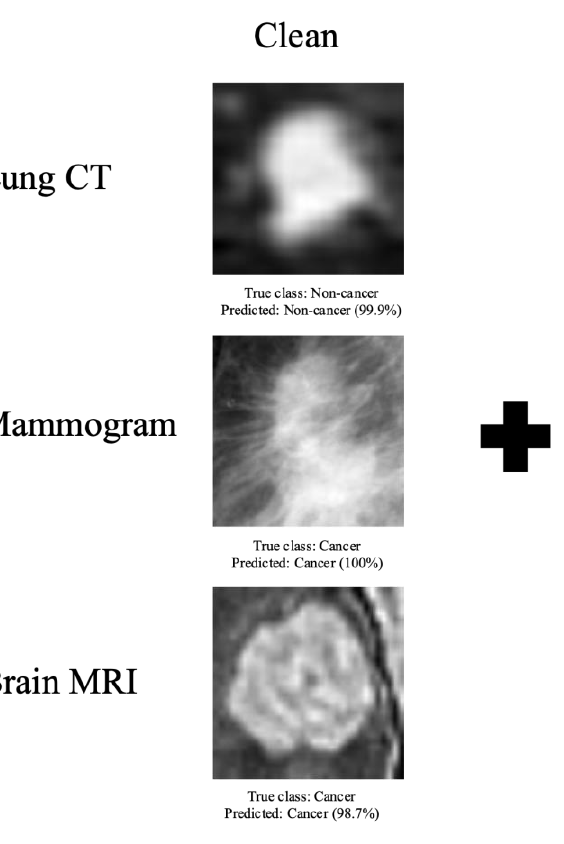
Figure 1. Examples of clean images, adversarial perturbations, and resulting adversarial images generated using PGD attack method. The percentage displayed represents the prediction confidence— the probability predicted by the DL model that the image is of a certain class. Adversarial perturbations cause a change in the DL model classification of the image.